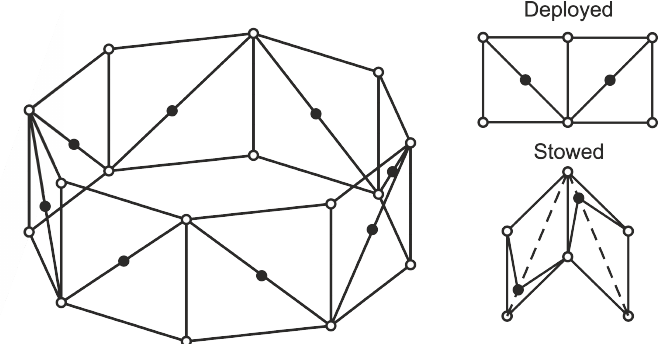
Figure 3. Octagonal opening system and elementary